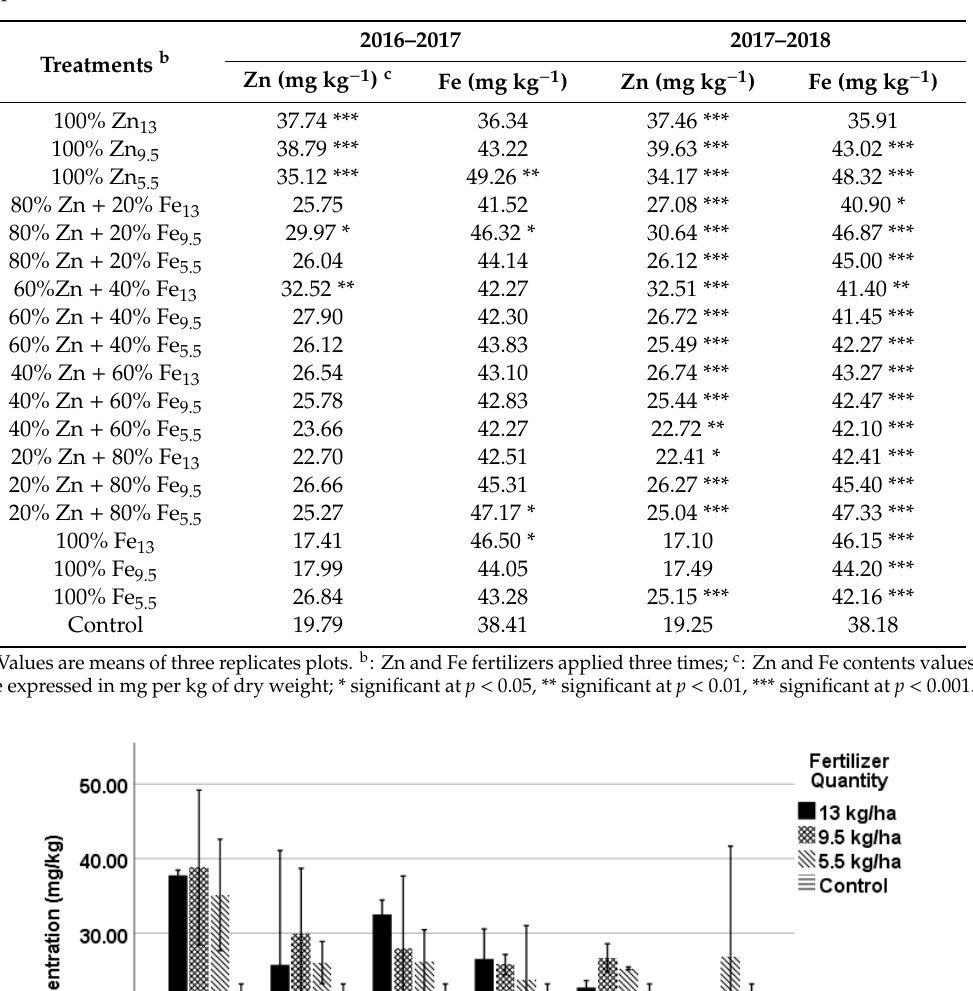
Table 5. Means comparison of Zn and Fe content of whole grain winter wheat a ff ected by foliar application of Zn and Fe fertilizers a .